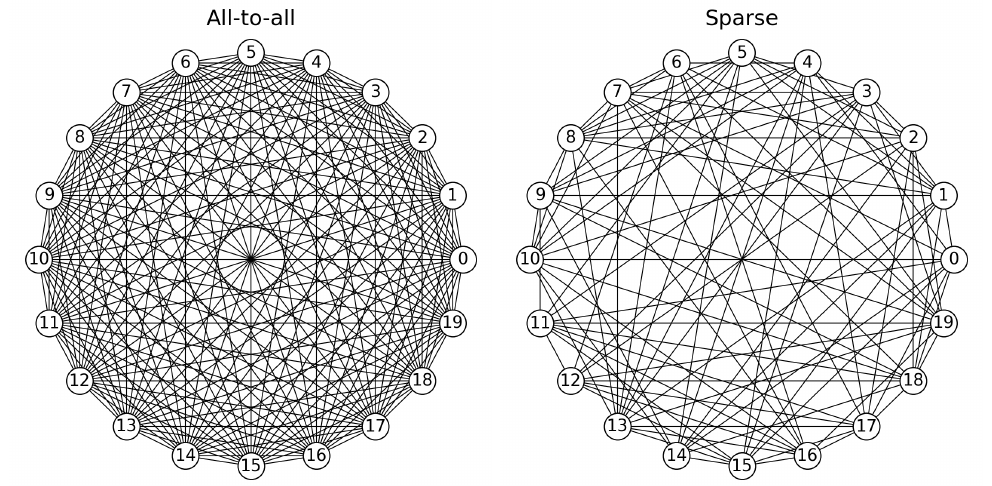
Figure 1. Hypergraphs associated to the Hamiltonians for the all-to-all SYK (Left) and sparse SYK from a ( k q, q ) -regular hypergraph (Right). The parameters used are N = 20 , q = 4 and k = 1 . For drawing purposes, each hyperedge is replaced by a complete set of